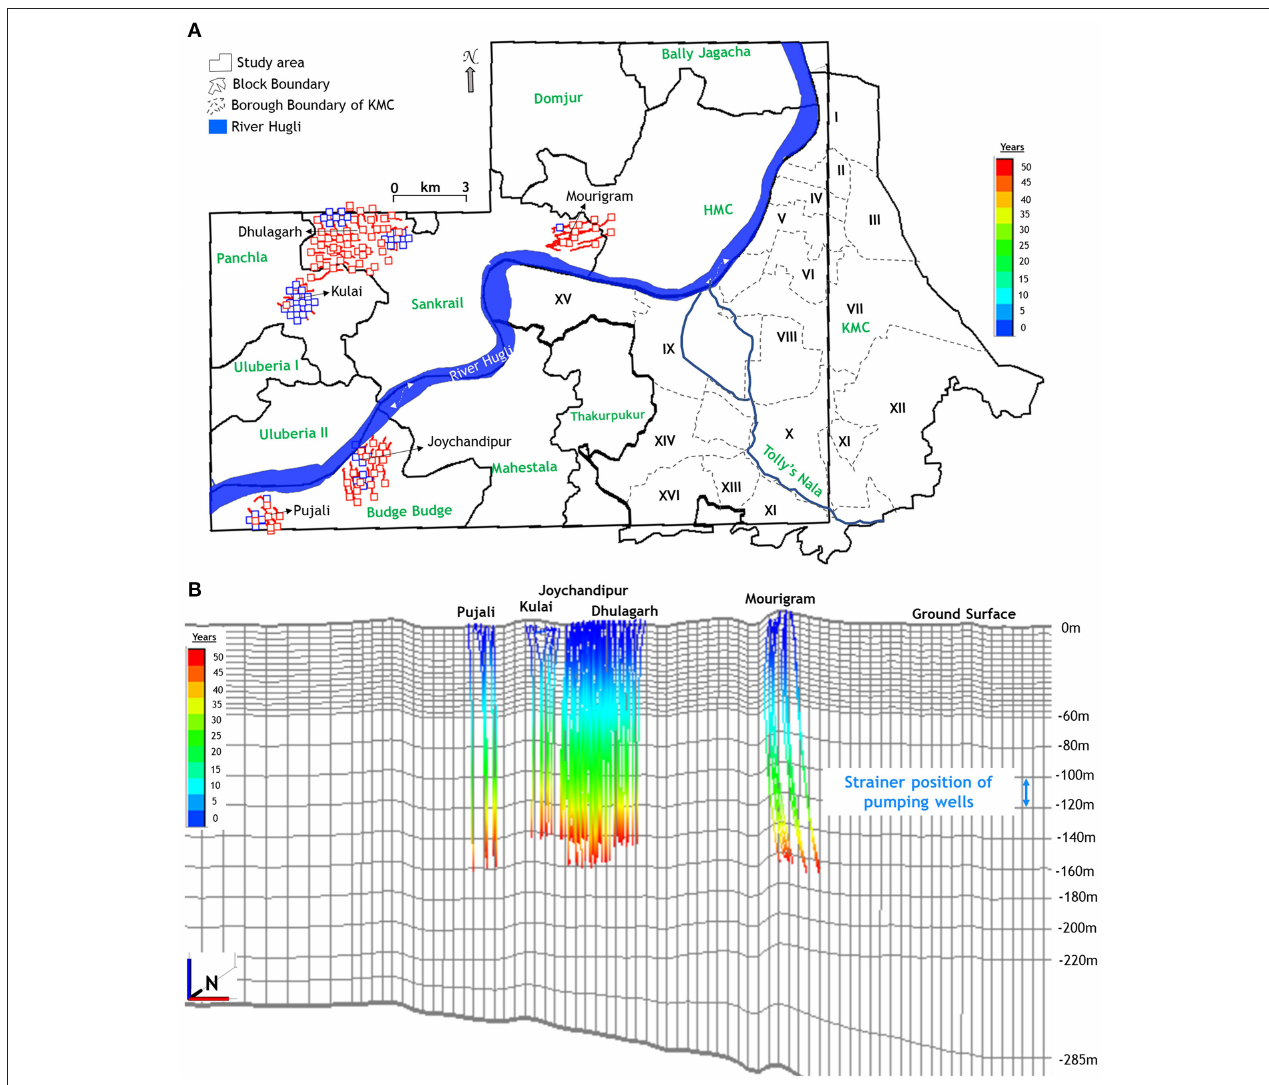
FIGURE 14 | (A) Path lines and endpoints of forward tracked particles, generated from the industrial areas outside KMC, within the next 50 years under present development pumping conditions. (B) 3-D view of particle path lines for 50 years from industrial areas into the aquifer under present development conditions; vertical exaggeration is